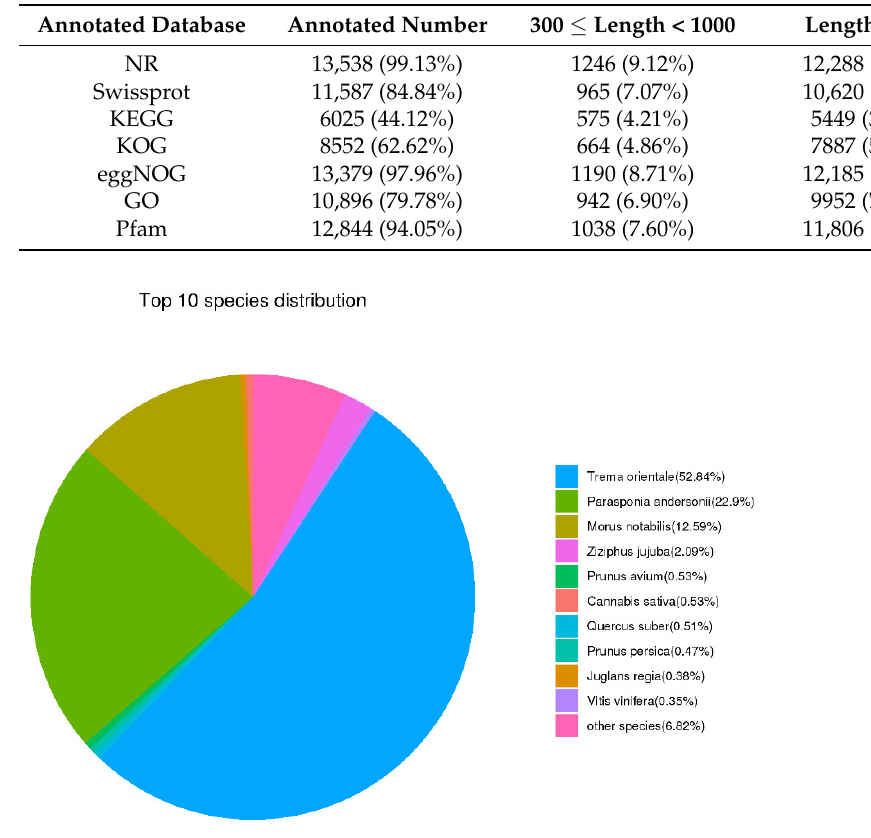
Figure 3. The classification statistics of non-redundant transcripts in NR database.